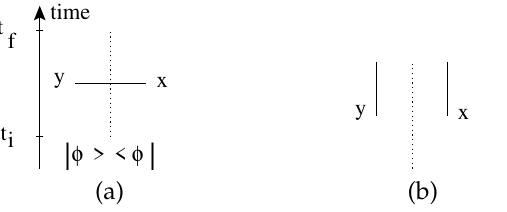
Figure 1. A solid line stands for the propagator in a CTP Feynman graph. The vertical dotted line sep- arates the ket and the bra sectors where the field variable φ + and φ − are used, respectively. The time runs upward. ( a ) The Wightman function D − + ( x − y ) connects the bra and the ket components. ( b ) An alternative representation of the Wightman function where the lines follow the world lines of the excitations until the final time when the trace operation carried out in (6) connect them. These excited states are on-shell.